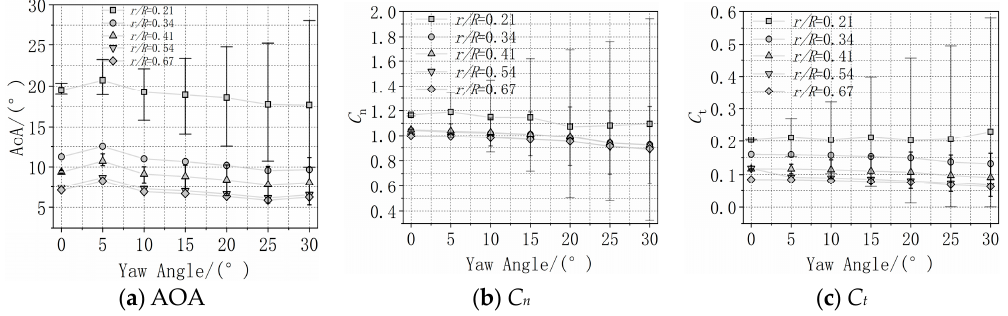
Figure 14. Variation of time-averaged AOA and aerodynamic load under yaw during one revolution.